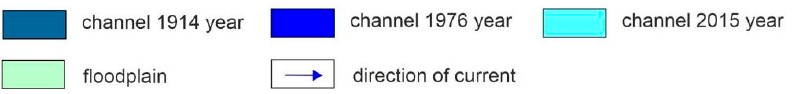
Figure 9. Comparison of the channel plans of the Irkut river in three time sections.